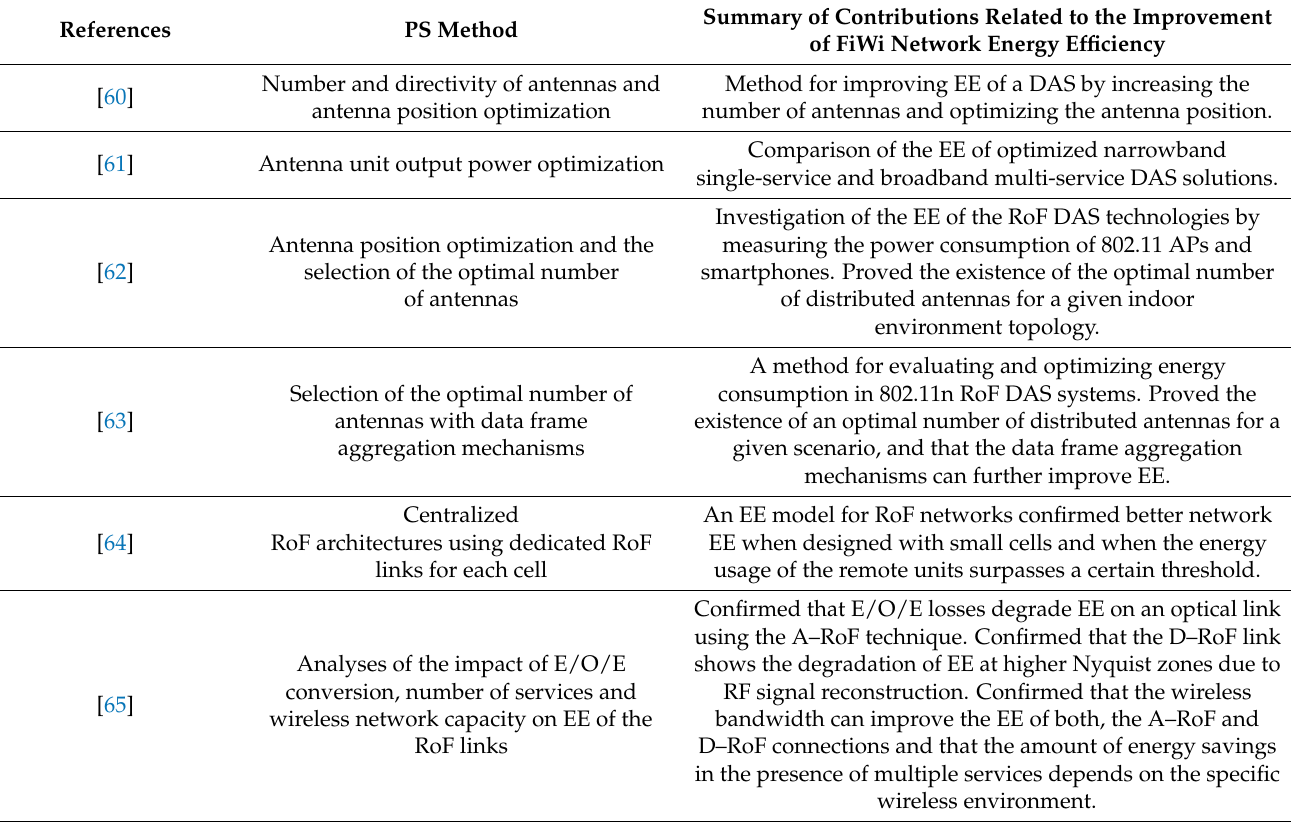
Table 2. Summary of the related works on PS methods in RoF